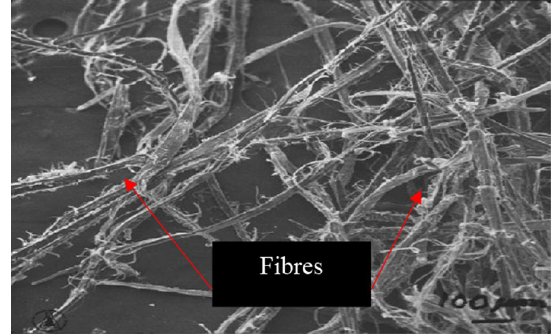
Fig. 2 SWP fibres (Prasad et al., 2015)